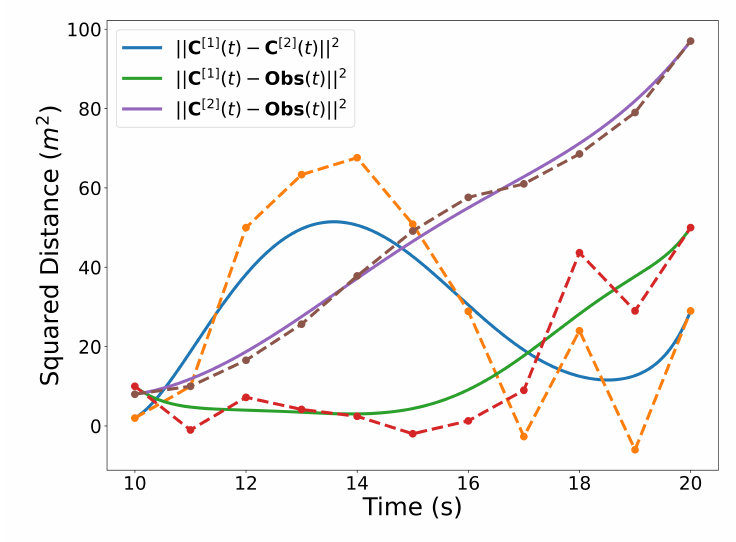
Figure 9. Squared distance between trajectories and the center of the circular